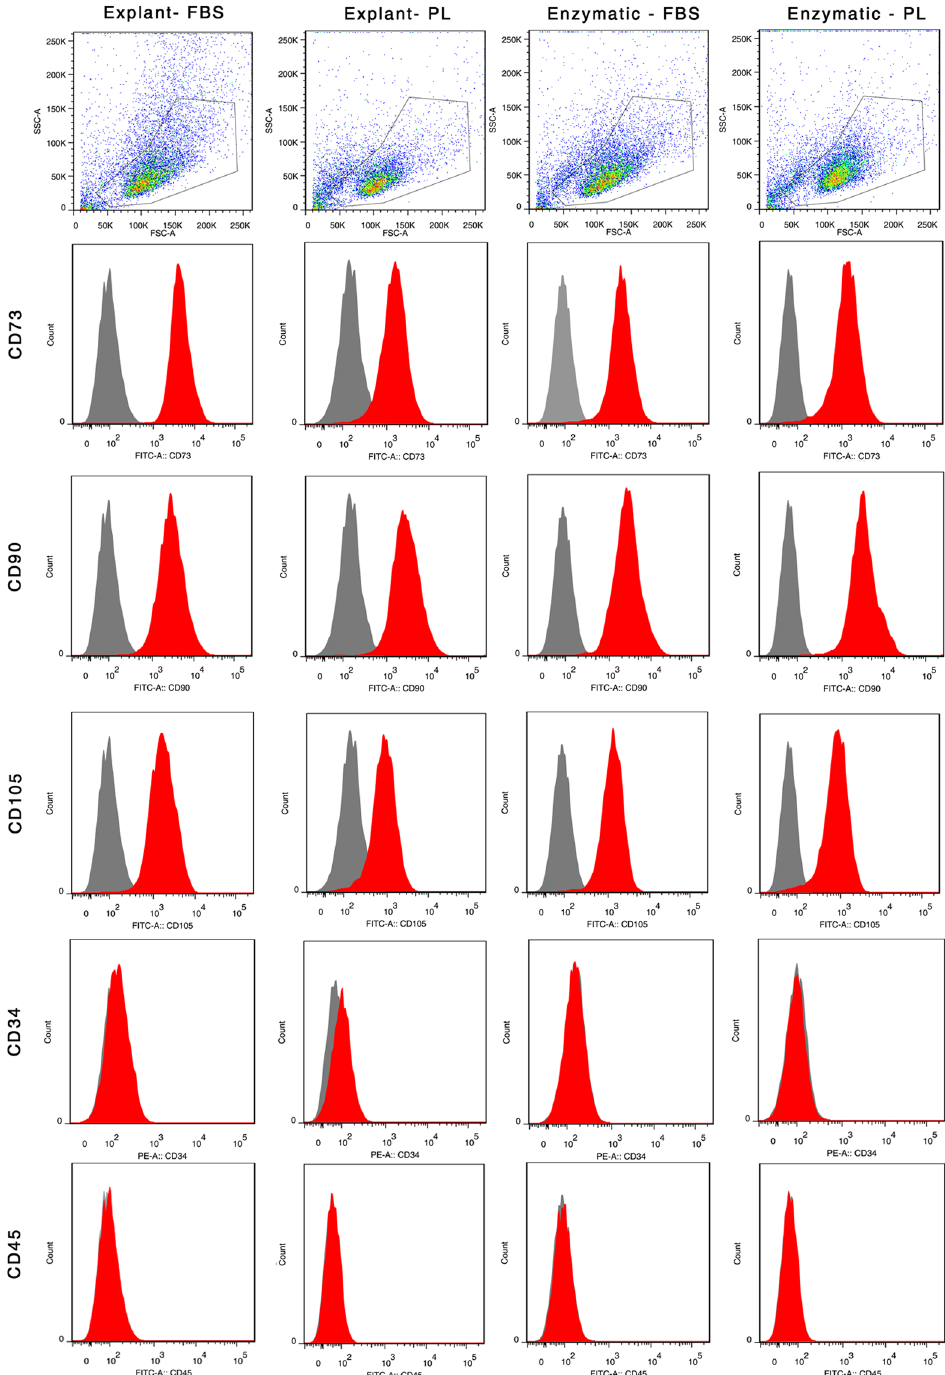
Figure 4. Immunophenotypic analysis by flow cytometry. Representative image of flow cytometry analysis of UC-MSC at passage 2 probed with conjugated antibodies against MSC and hematopoietic markers CD73, CD90, CD105, and CD34, CD45